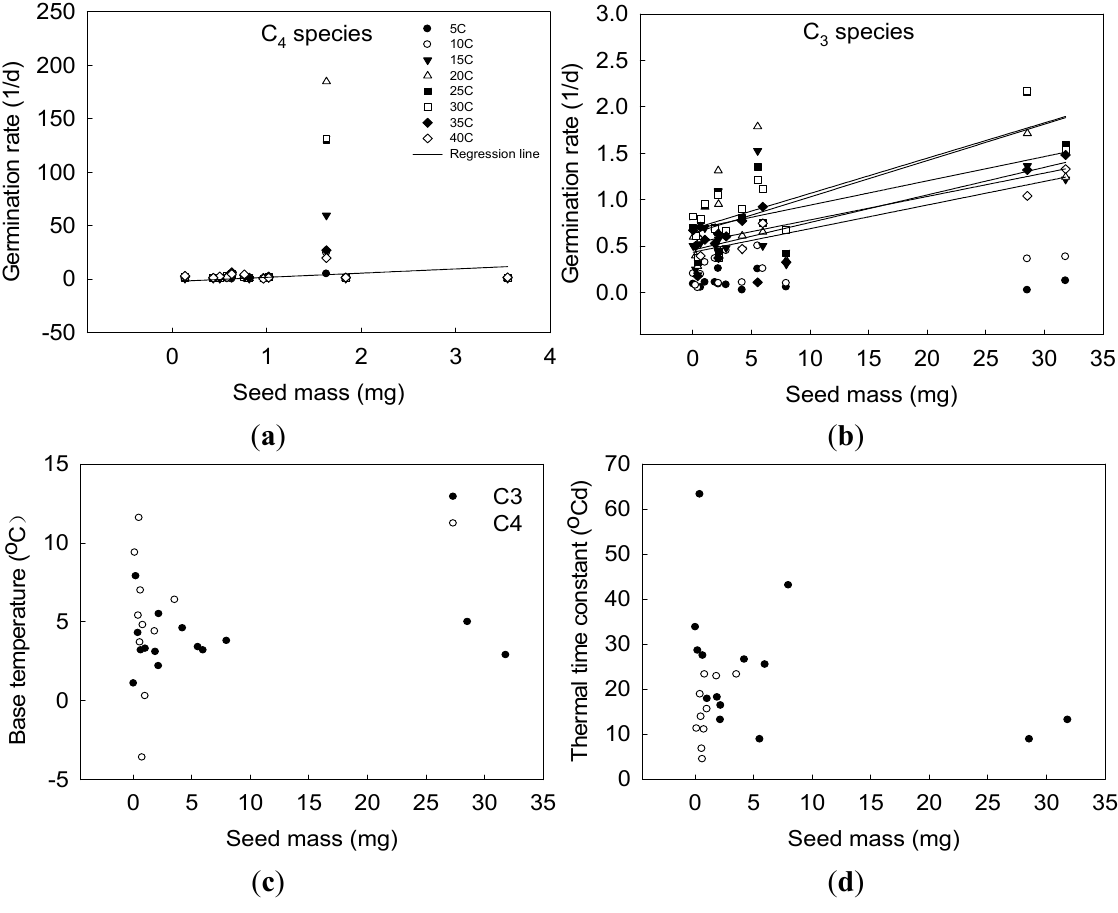
Figure 5. The relationship between seed mass and germination parameters of C 3 and C 4 species (germination rate, ( a ), ( b ); base temperature, ( c ); thermal time constant, ( d ); significant linear regressions were given in figures ( a ), 5 °C; ( b ), 15 °C, 20 °C, 25 °C, 30 °C, 35 °C, 40